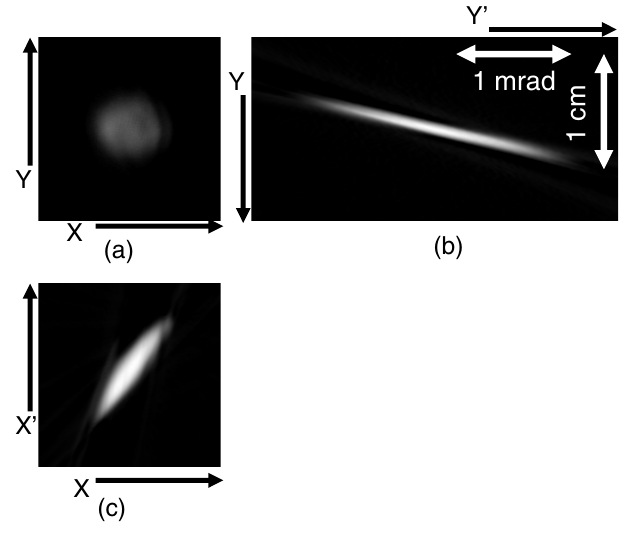
FIG. 11. Phase space tomography results along the UMER injector line: (a) spatial distribution at the point where recovery is done; (b) Y 0 Y tomographic recovery of the electron beam; (c) X 0 X tomographic recovery of the electron beam.